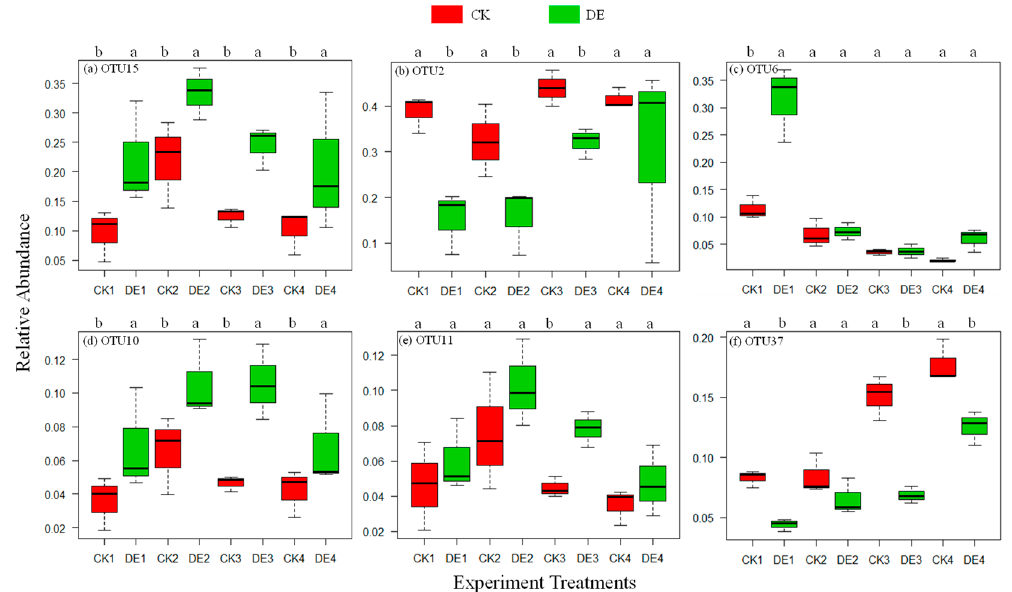
Figure 5. Relative abundance of the dominant nitrifying microorganisms in different soil treat- ments on day 16 of incubation. Note: ( a ) OTU15, ( b ) OTU2, ( c ) OTU6, ( d ) OTU10, ( e ) OTU11, ( f ) OTU37. CK, ordinary water; DE, ionized water, θ FC , soil water content at field capacity. Numbers in the treatment labels: 1, 30% θ FC ; 2, 60% θ FC ; 3, 100% θ FC and 4, 175% θ FC . Different lowercase letters indicate significant differences between different water treatments with the same moisture content ( p < 0.05).